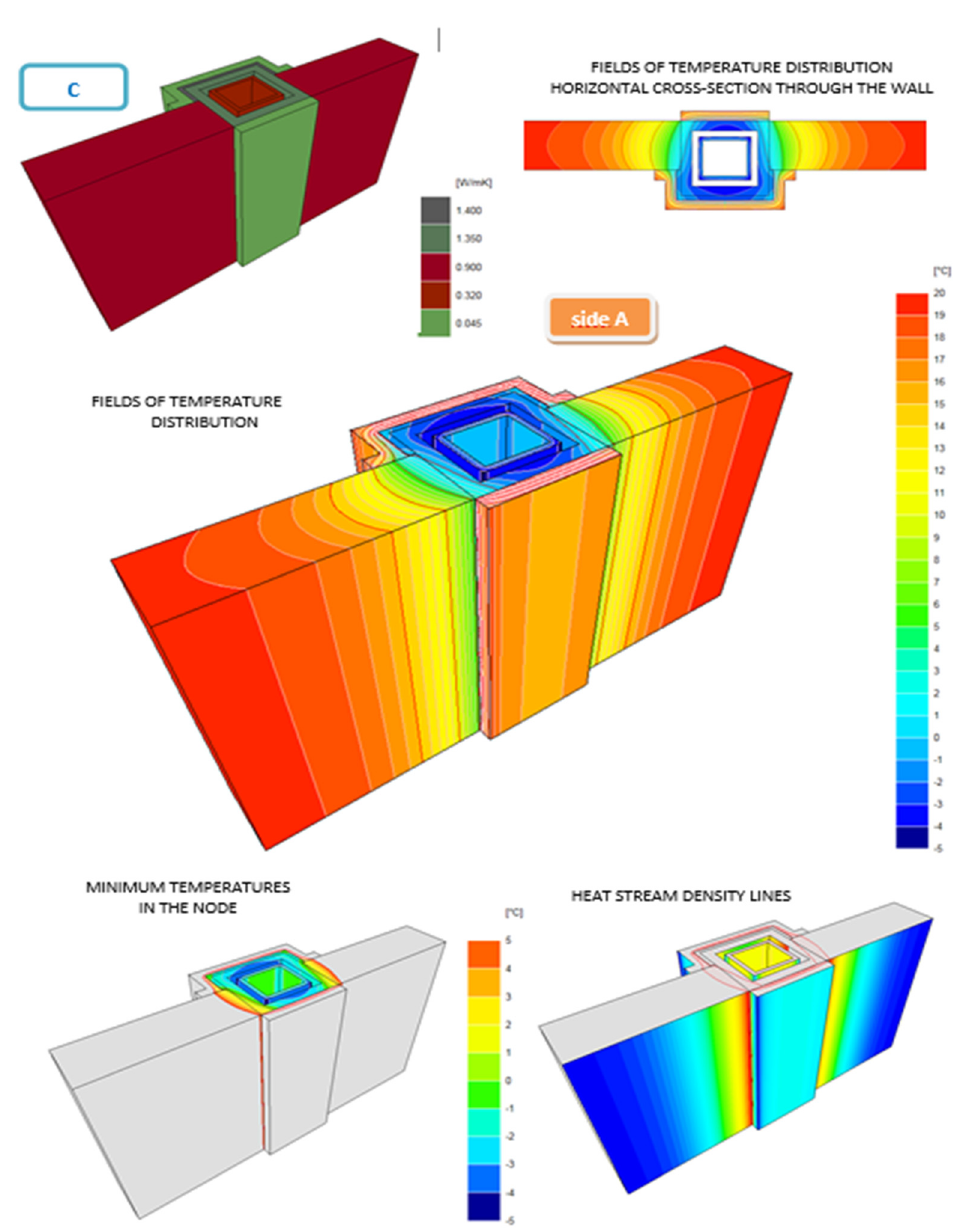
Figure A3. Scheme C: isotherm field distribution, minimum surface temperature, and heat flux distribution.